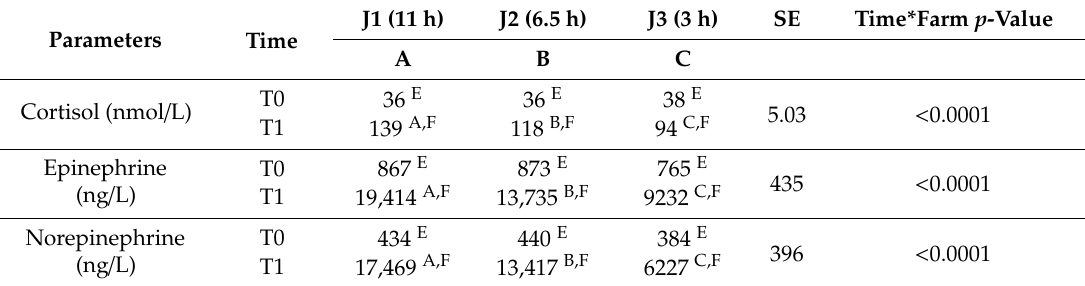
The deck-journey distance interaction was not significant on epinephrine, norepinephrine or cortisol levels collected at arrival (T1). There was a significant e ff ect of deck level on norepinephrine levels ( p < 0.0001), a tendency to